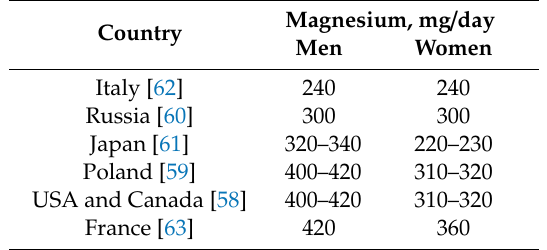
Table 3. Current magnesium recommended dietary allowances (RDAs) across countries.